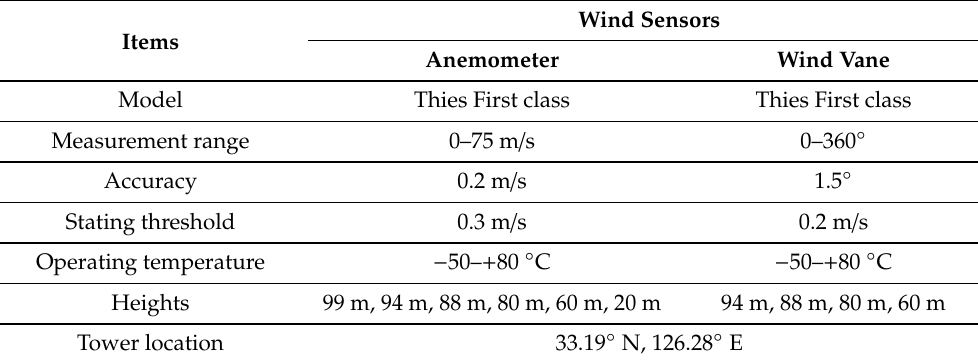
Figure 1. Location of Jeju Island and measurement site in Daejeong. Table 1. Specifications of wind sensors of the met-mast.